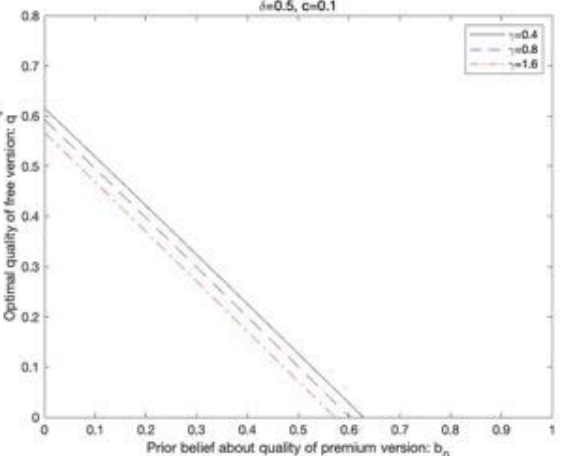
Figure 6. The impact of prior beliefs 𝑏 0 on free trial strategy design.